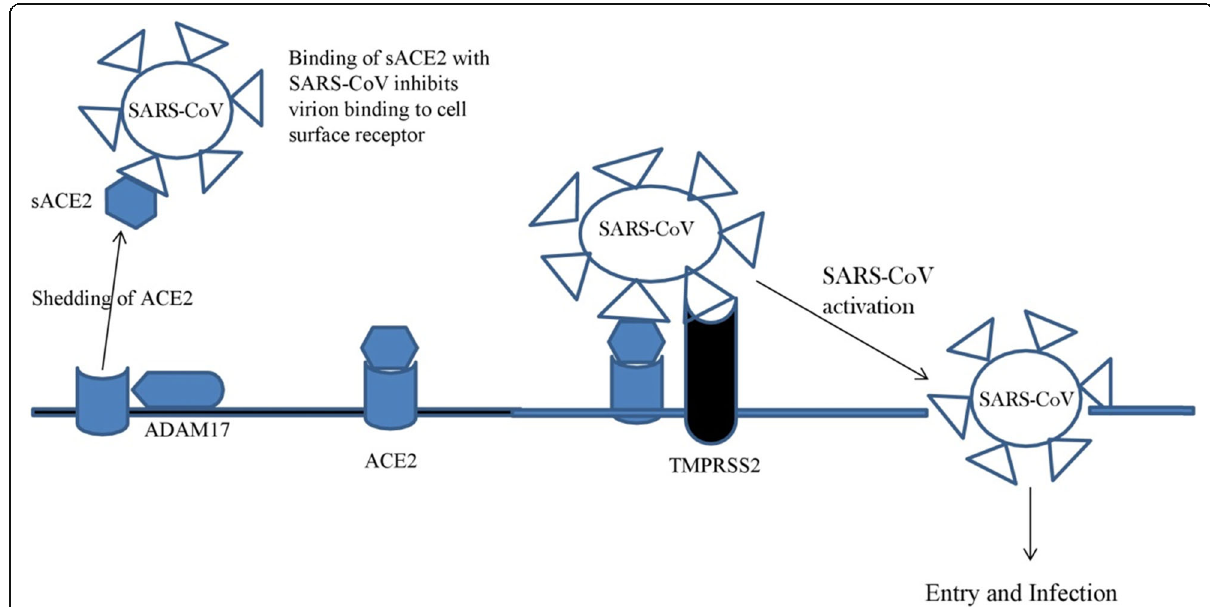
Fig. 2 Action of host cell proteases on ACE2 receptor [adapted from 35]. Cleavage of ACE2 by ADAM17 causes its shedding. Interaction of sACE2 with S-Protein of SARS-CoV prevents binding of virus particles to target cells. Co-expression of TMPRSS2 with ACE2 on target cell surface involves binding of SARS-CoV (S-protein) to ACE2- and TMPRSS2-mediated processing allows fusion and uptake of virus